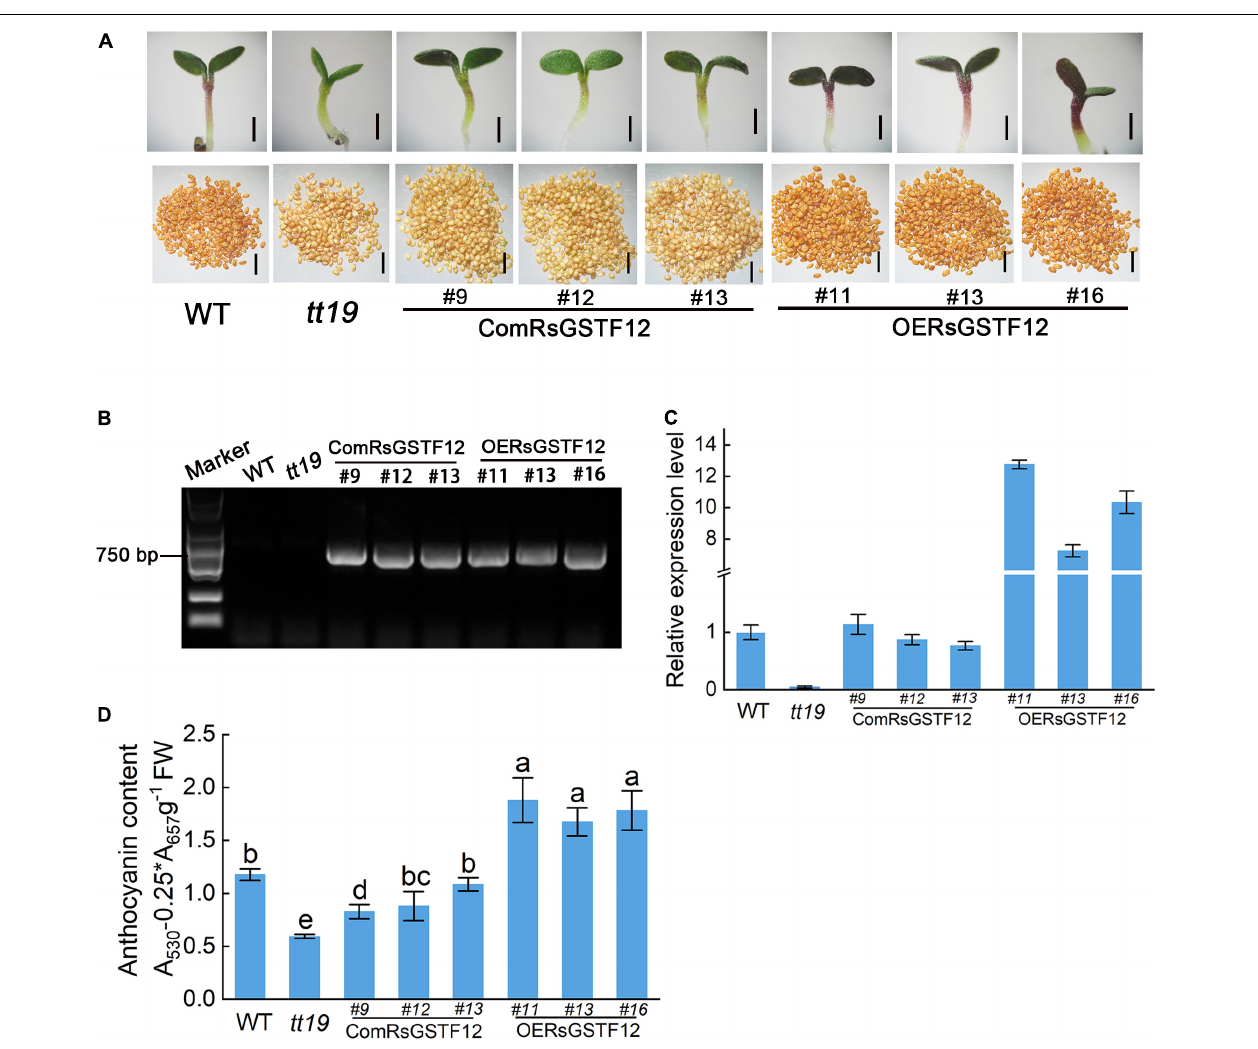
FIGURE 6 | RsGSTF12 increases the anthocyanin accumulation in transgenic Arabidopsis seedlings. (A) Phenotypes of the seedlings and seeds of RsGSTF12 transgenic Arabidopsis. Scale bar = 500 nm. (B) Identification of the RsGSTF12 fragment in ComRsGSTF12 and OERsGSTF12 transgenic lines of Arabidopsis seedlings. (C) The relative expression levels of AtGSTF12 and RsGSTF12 in the wild-type, mutant, and transgenic seedlings of Arabidopsis. (D) Anthocyanin content in the wild-type, mutant, and transgenic seedlings of Arabidopsis. Seven-day-old seedlings were cultivated on 1/2 Murashige and Skoog (MS) medium with 6% sucrose. Data in panel (D) are presented as the mean ± standard deviation (SD) whose significant differences are indicated by differing lowercase letters according to the Duncan’s multiple range test ( p < 0.05).